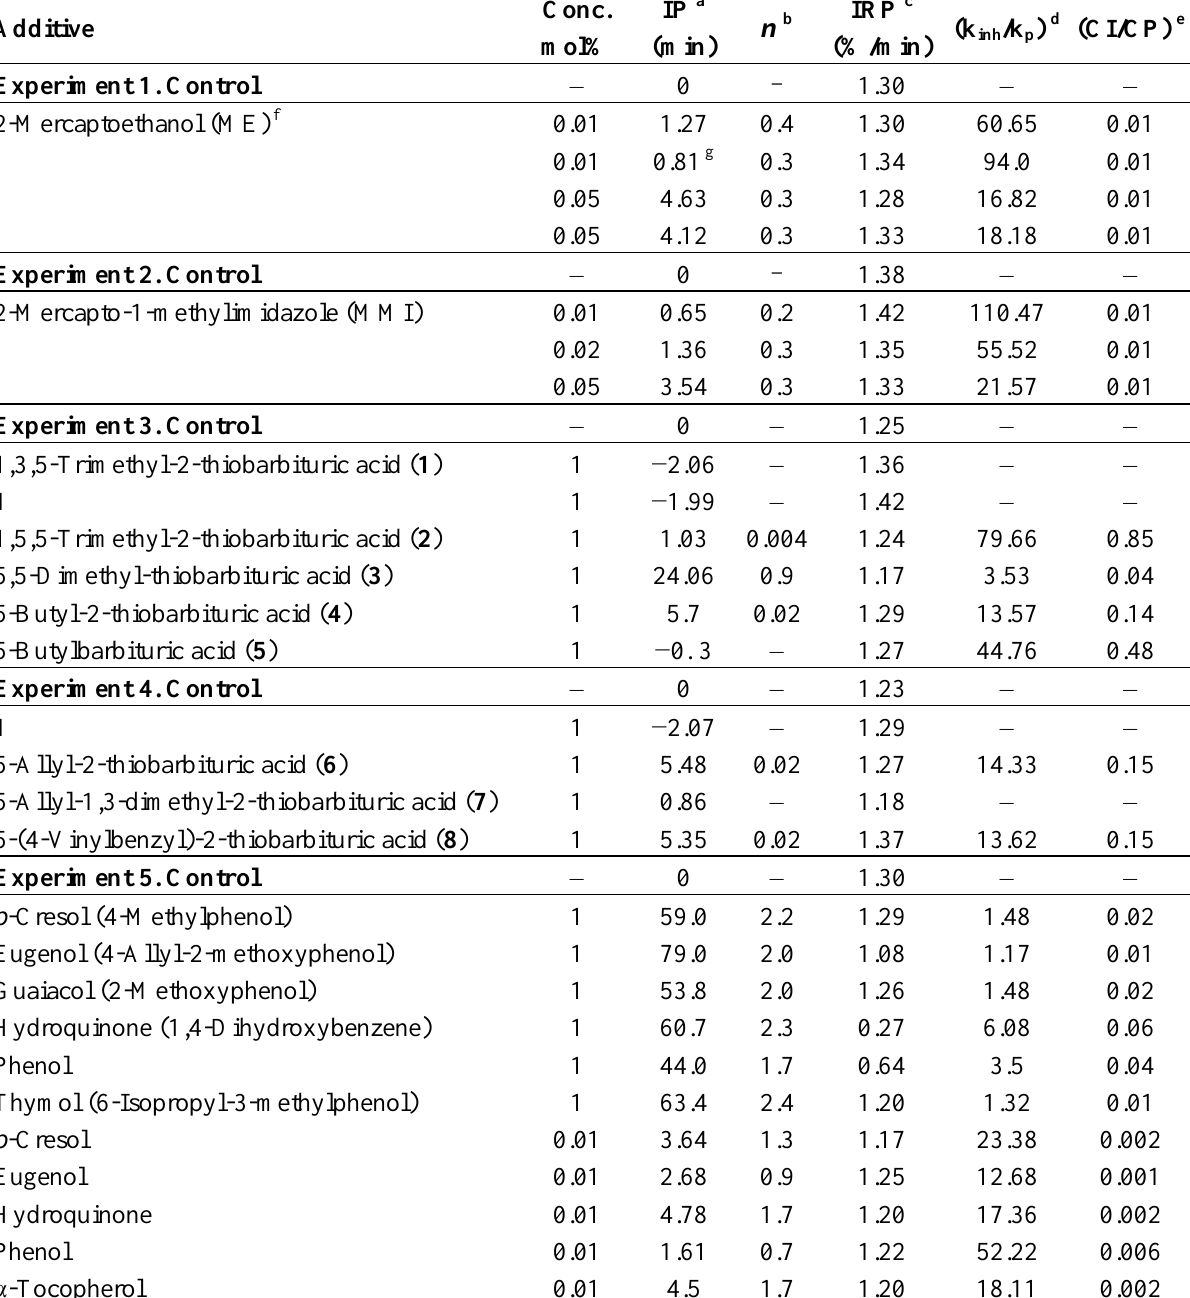
Table 3. Radical-scavenging activity for thiols, thiobarbituric acid derivatives and chain-breaking phenolic